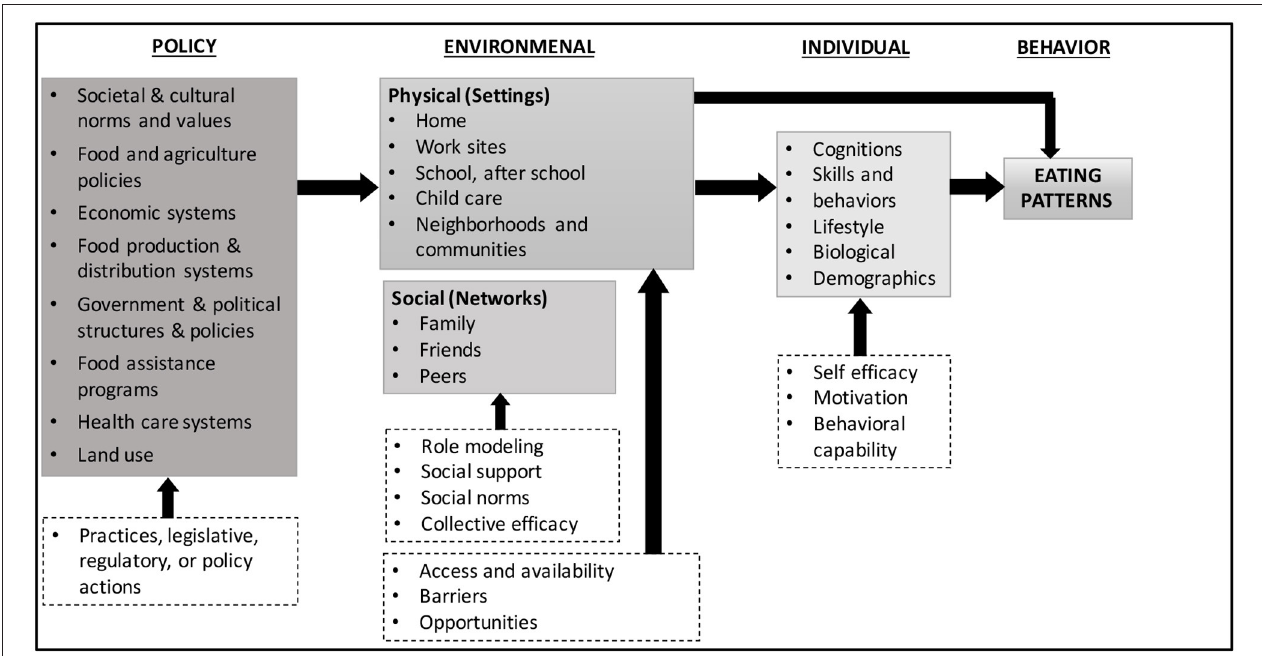
FIGURE 1 | Ecological framework depicting multiple influences on what people eat [adapted from Story et al.